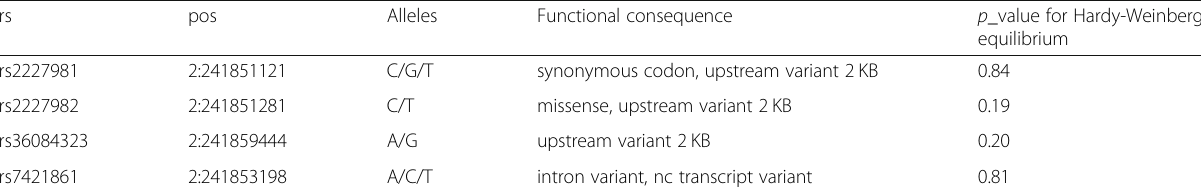
Table 2 Basic information of